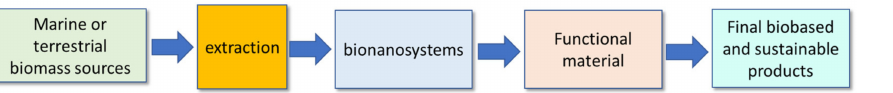
Figure 1. Scheme followed by the present review to discuss rosmarinic acid and ulvan potentialities in bionanosystems and final biobased products.